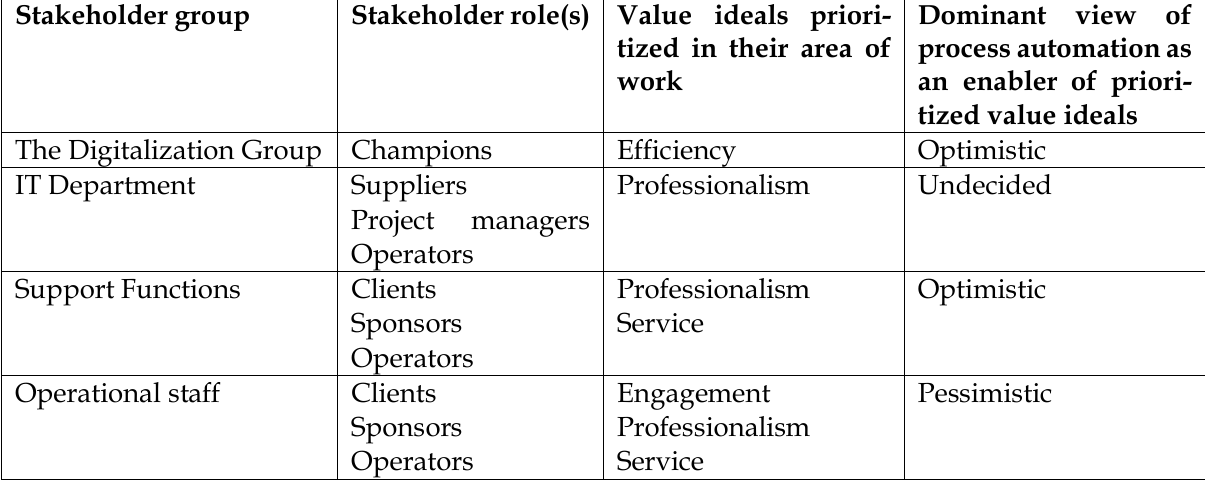
Table 3. An overview of our